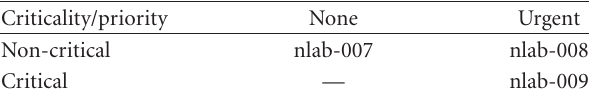
Table 1: The three simulated